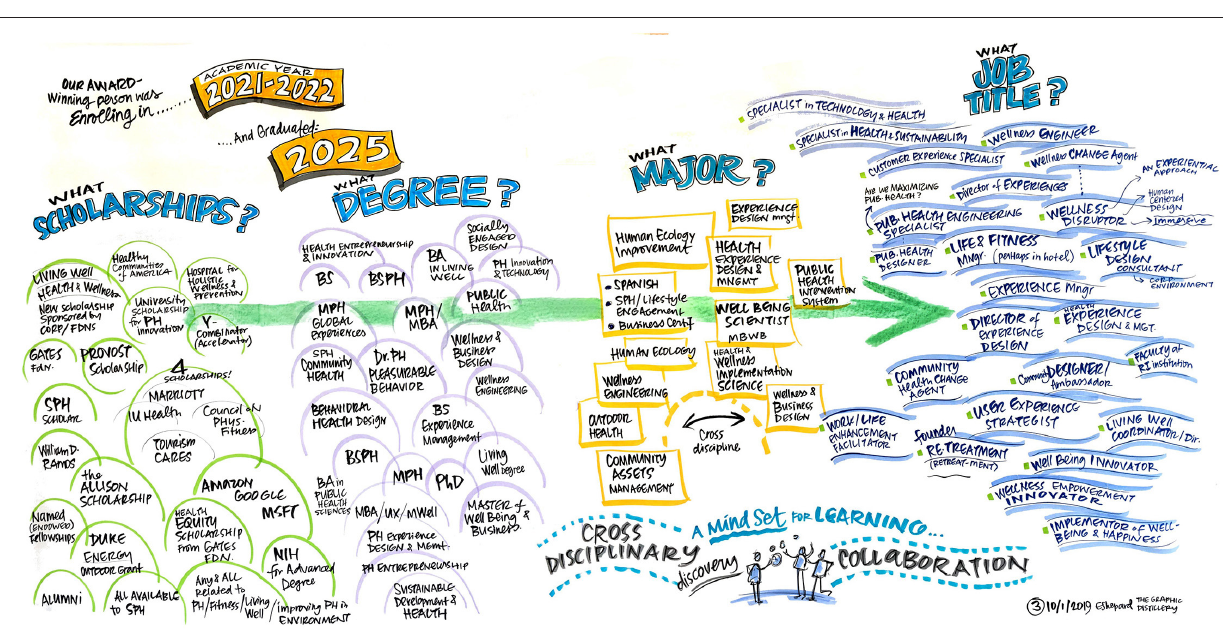
recreation, and tourism industries. Upon shifting to our new home in the School of Public Health, changes to the curriculum at both the undergraduate and graduate levels occurred incrementally. In the following paragraphs we discuss how our curriculum has evolved as a